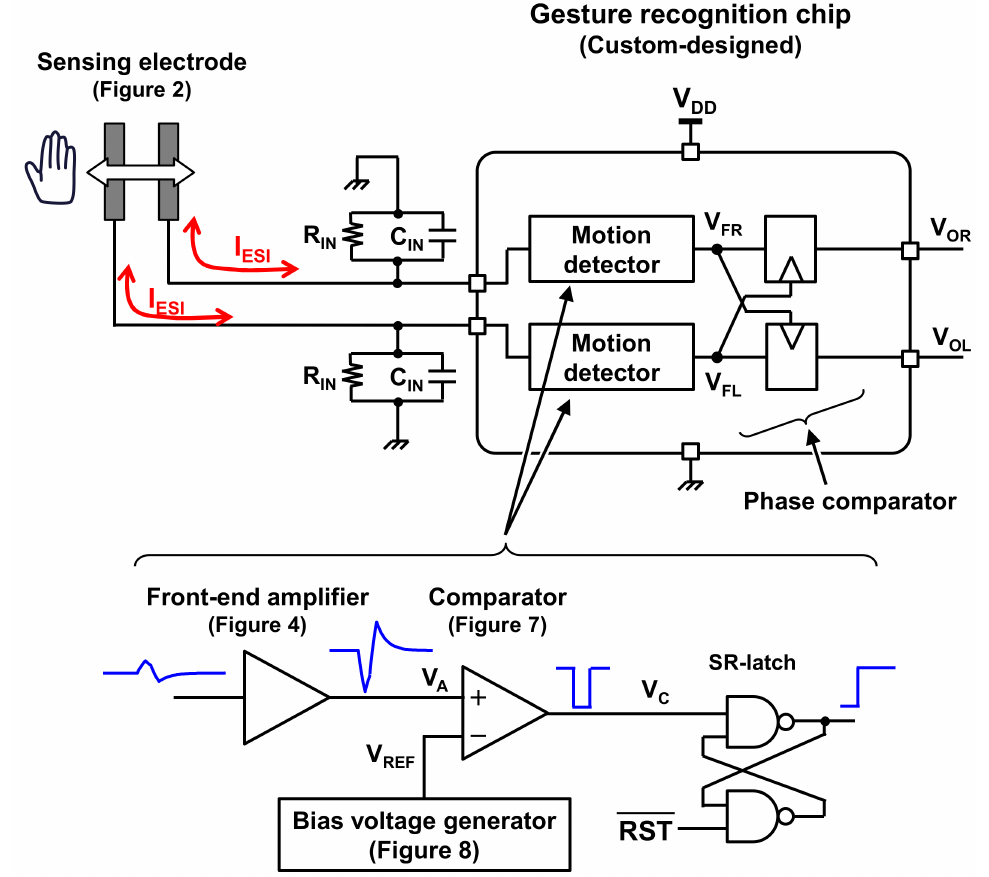
Figure 1. Overview of the proposed hand gesture sensor system. This system consists of sensing electrode using an electret (Figure 2) and a gesture recognition chip, which is first designed in this study to achieve ultra-low power gesture